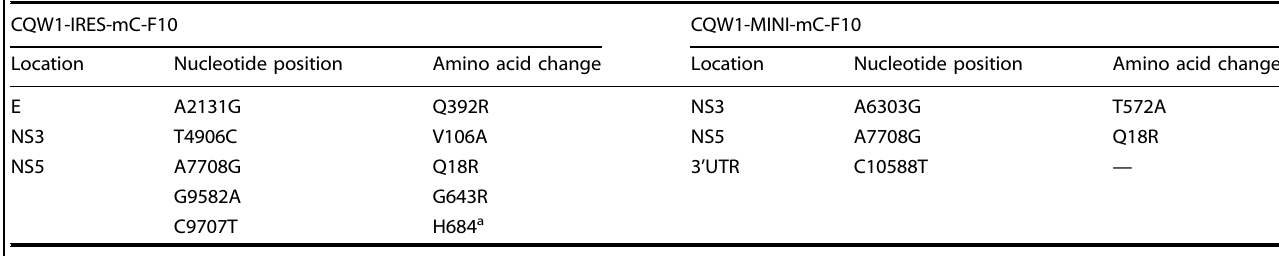
Table 1. Continuous passages of CQW1-IRES-mC and CQW1-MINI-mC on BHK-21 cells.